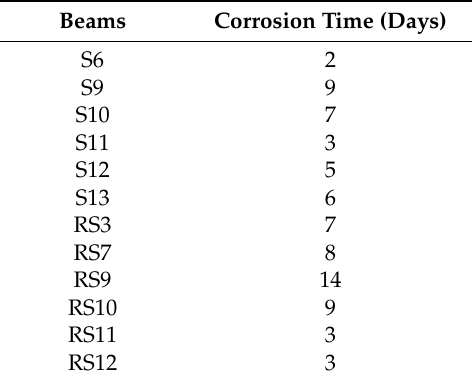
Table 6. Accelerated time of specimens.